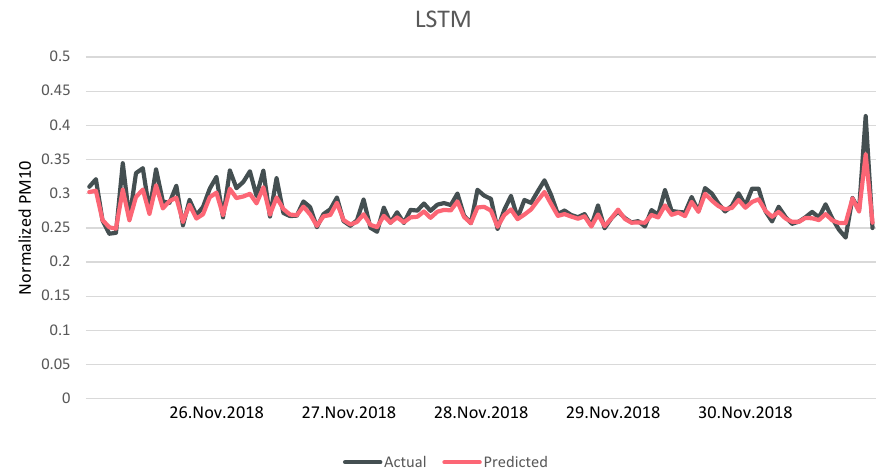
Figure 12. Comparison between the Long short-term memory (LSTM) prediction and the test data.